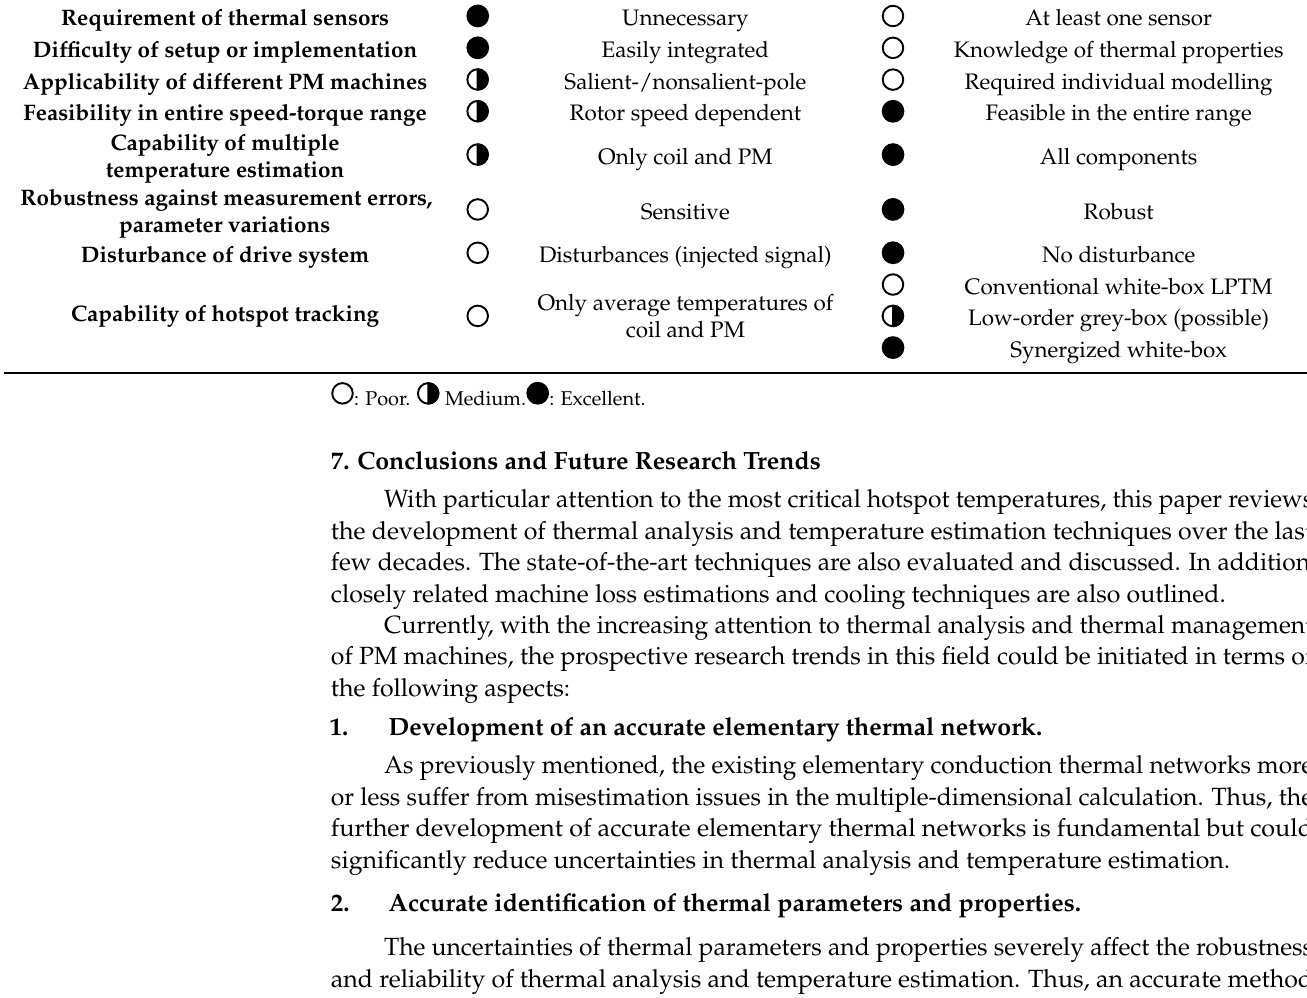
Table 4. Evaluation of common cooling techniques for electrical machines.